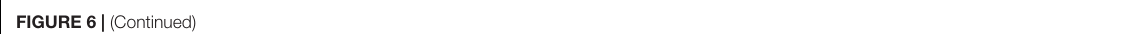
( Figure 3A ). Fluorescence quantitative PCR analysis